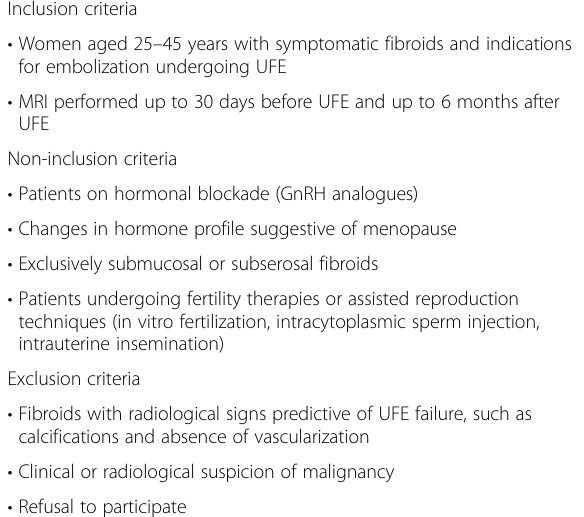
Table 1 Inclusion, non-inclusion, and exclusion criteria Inclusion